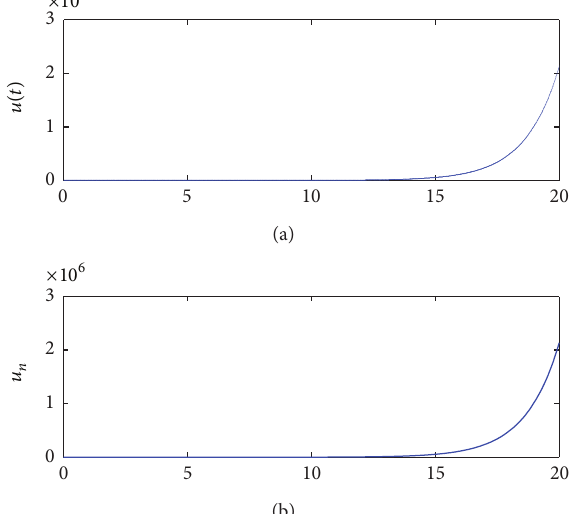
Figure 5: The analytic solution and the numerical solution of (40) with 𝑛 = 3 and 𝑚 = 40